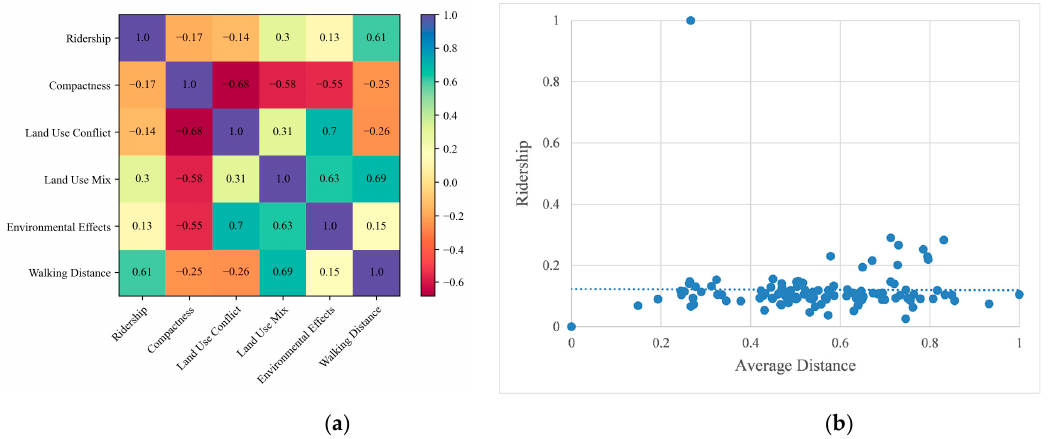
Figure 9. Relationships between the planning objectives: ( a ) Coefficient confusion matrix; ( b ) Rela- tionship between the average walking distance and ridership.